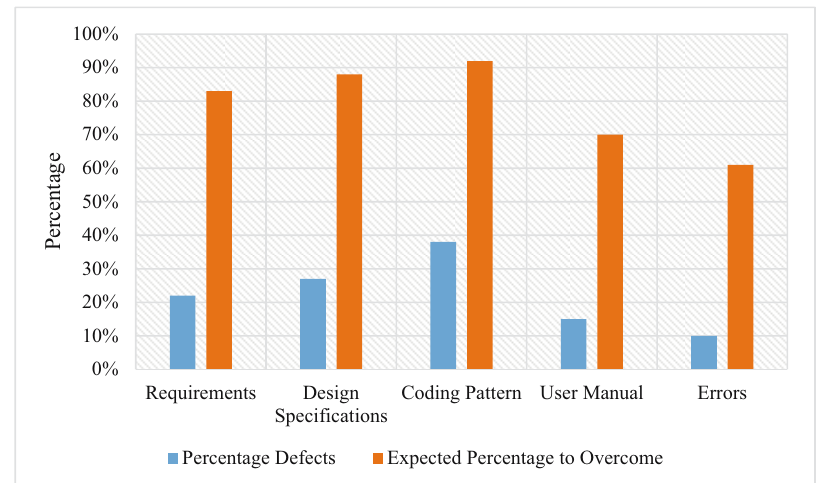
Figure 4: Di ff erent phases of software